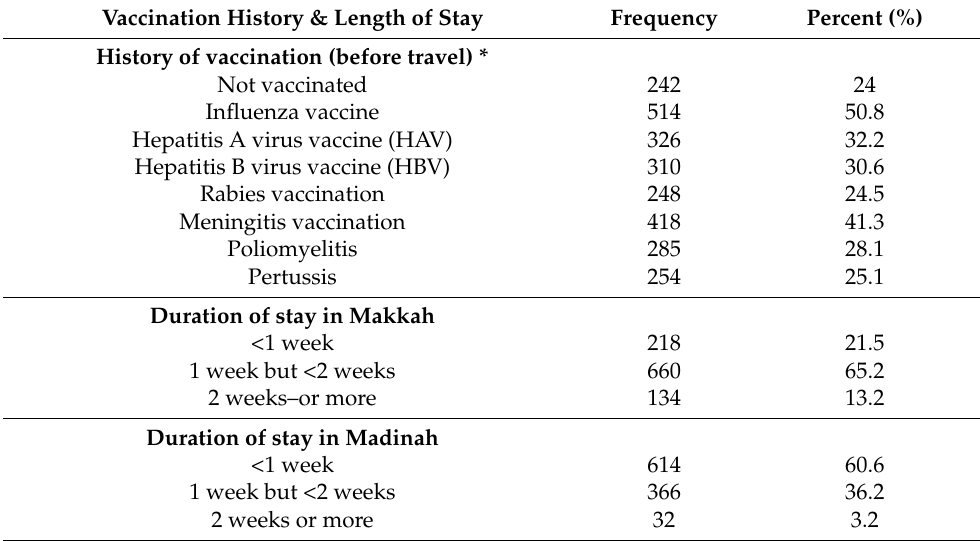
Table 3. Responses to items on aspects of vaccination history and the average duration of stay in Makkah and Madinah ( n =